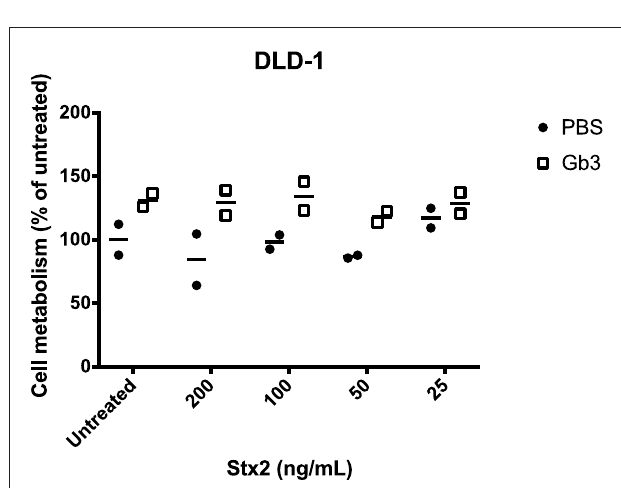
FIGURE 5 | Exogenous administration of Gb3 did not introduce Stx2 susceptibility in DLD-1 cells. DLD-1 cells were incubated with Gb3-containing liposomes or PBS control followed by incubation with Shiga toxin 2 (Stx2) for 24h. No significant difference in cell metabolism could be seen in PBS-treated or Gb3-liposome treated cells at any of the Stx2 concentrations. Median cell metabolism is denoted by the